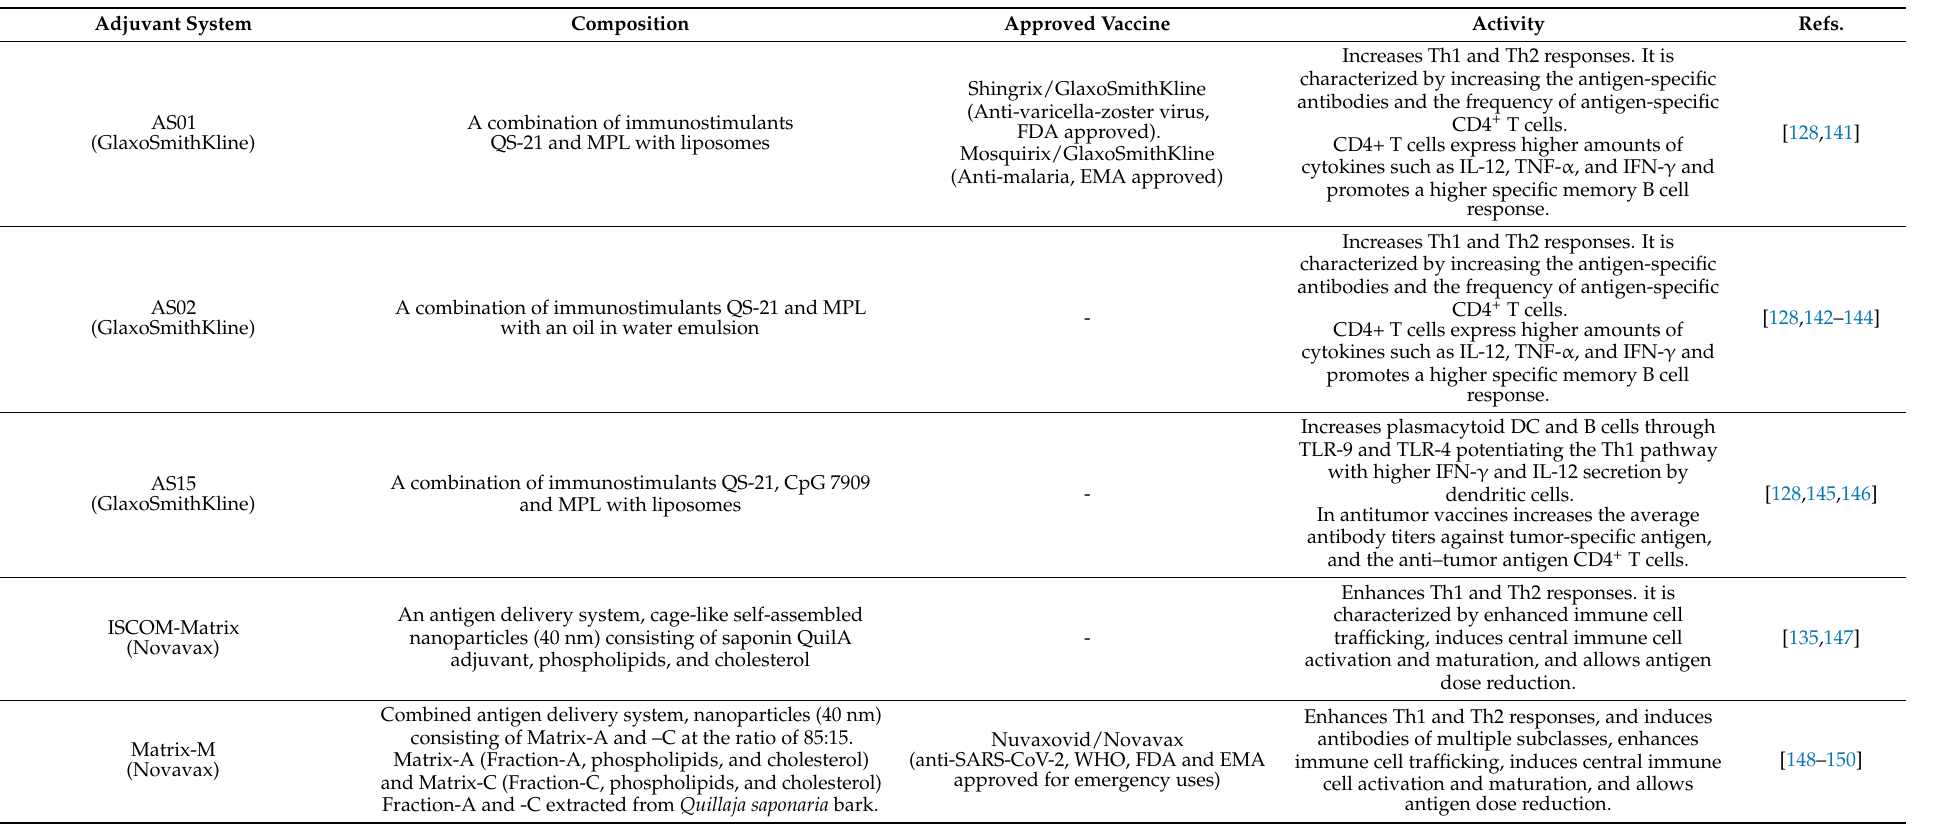
Table 2. Saponin-based adjuvant systems (licensed) that have been used in the development of approved vaccines for human uses. Adjuvant